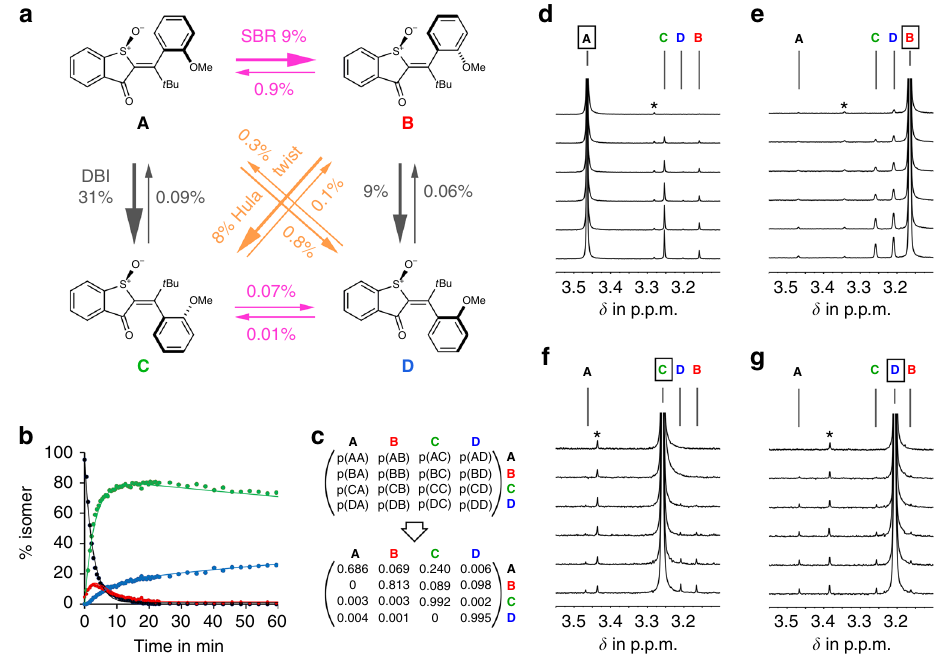
Fig. 3 Photochemistry of 1 in benzene- d 6 solution. a Individual photoconversions between the four isomers of 1 in benzene- d 6 under 405 nm irradiation experimentally determined by quantum yield measurements. b Fitting of experimental data obtained at 27 °C in benzene- d 6 (dots) to a global kinetic model (lines) for the photoconversion of individual isomers starting from pure A . c Markov matrix describing the phototransition probability between individual isomers (starting isomer to product isomer) within one minute of irradiation in benzene- d 6 . Numeric values were obtained from the best global fi t to the experimental data. The ratios between off-diagonal elements mirror the ratios of the measured quantum yields for individual phototransitions. The diagonal elements describe the percentage of remaining starting isomer after one minute of irradiation. d – g Indicative sections of 1 H NMR spectra (400 MHz, 27 °C, benzene- d 6 ) recorded during irradiation of each pure isomer A ( d ), B ( e ), C ( f ), and D ( g ) at 23 °C. Different photoproducts are generated at